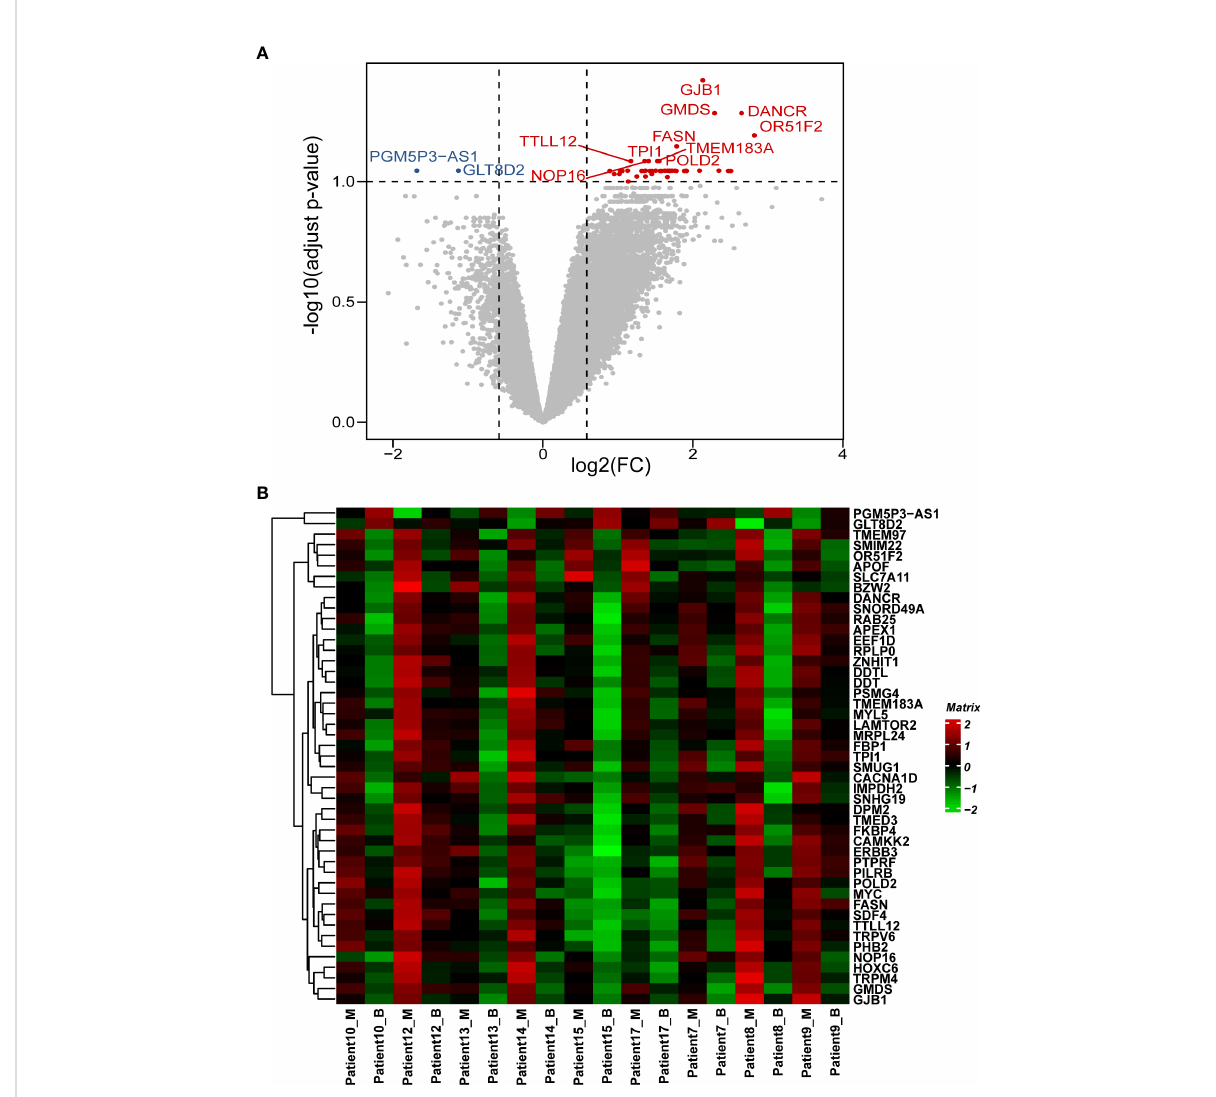
FIGURE 1 Patterns of differential expression in paired PCa samples. (A) Volcano plot of the DEGs between paired benign and malignant prostate samples. This graph is formed by plotting the log2(fold change) on the x-axis and calculating the -log10(adjusted p-value) along the y-axis. The red dots indicate genes that are upregulated (with labelled names), the blue dots indicate genes that are downregulated (with labelled names), and the black dots represent genes that are stable. The top 10 dysregulated genes were labelled. (B) Heatmap of the DEGs between the benign and malignant prostate samples. The genes are clustered vertically. Using the colour legend bar on the right-hand side, red represents high gene expression, green represents low gene expression, and black represents no gene expression. The expression values range from -2 to 2. DEG, differentially expressed gene. PCa, prostate cancer; M, malignant; B,